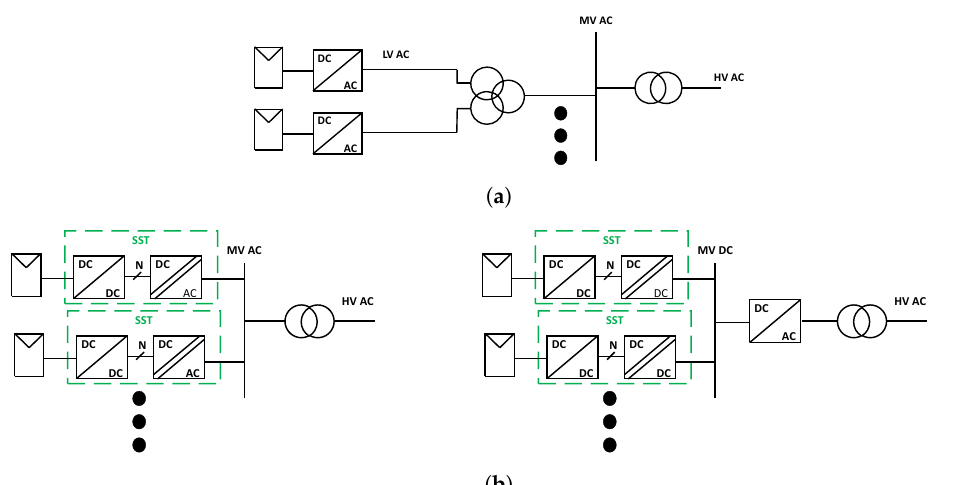
Figure 10. ( a ) Classical approach for power delivery at utility-scale solar PV plant. Black dots indicate multiple solar arrays connected in parallel. ( b ) Two SST configuration alternatives.